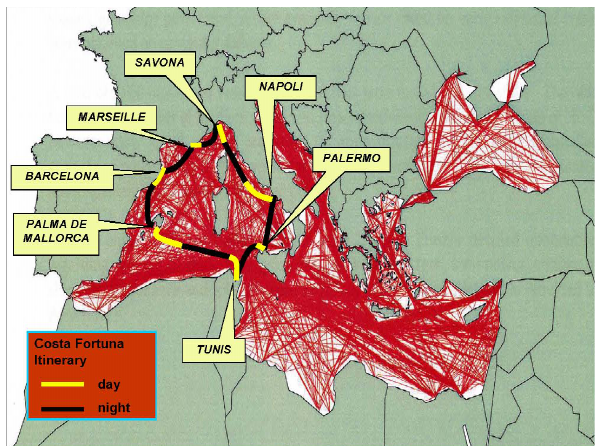
Fig.3. The route of Cost Fortuna during the period April-October 2006 and 2007. The red lines indicate ship trajectories in the Mediterranean (adapted from the Lloyd Register Report Fig. 3. The route of Cost Fortuna during the period April- 99/EE/7044, Lavander, 2001). “Day” is 7 AM to 7 PM LT, ‘Night’ is 7 PM to 7 AM LT. October 2006 and 2007. The red lines indicate ship trajecto- ries in the Mediterranean (adapted from the Lloyd Register Re- port 99/EE/7044, Lavander, 2001). “Day” is 07:00a.m. to 07:00p.m.LT, “Night” is 07:00p.m. to 07:00a.m.LT.